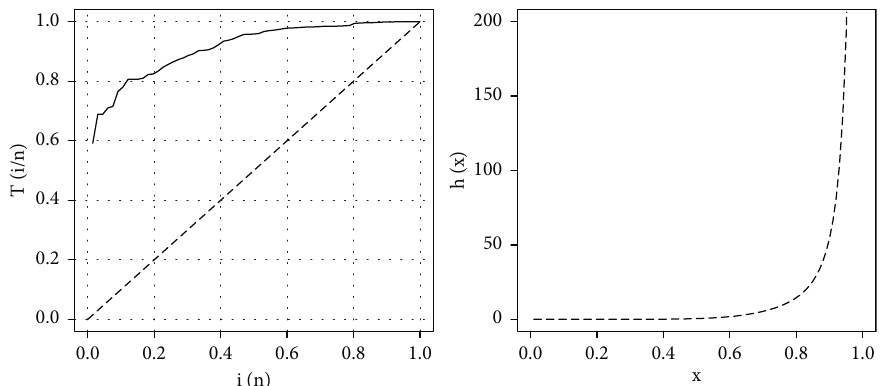
Figure 11: TTT plot and fitted HRF of ExRK model for the COVID-19 data set.